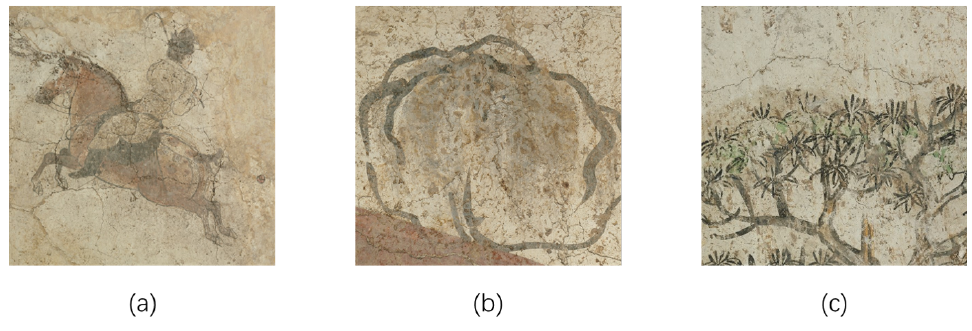
Figure 1. Feature network design: ( a ) person and horse; ( b ) stone; ( c )